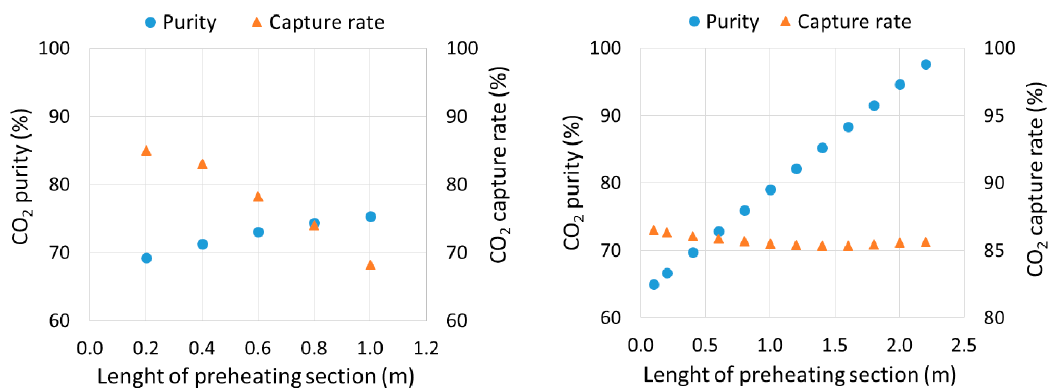
Figure 4. Effect of amount of length of preheating section on process performances for configuration B ( left ) and configuration D ( right ). Table 5. Effect of length of preheating section on process performances for configuration B. Simulation ID (unit)